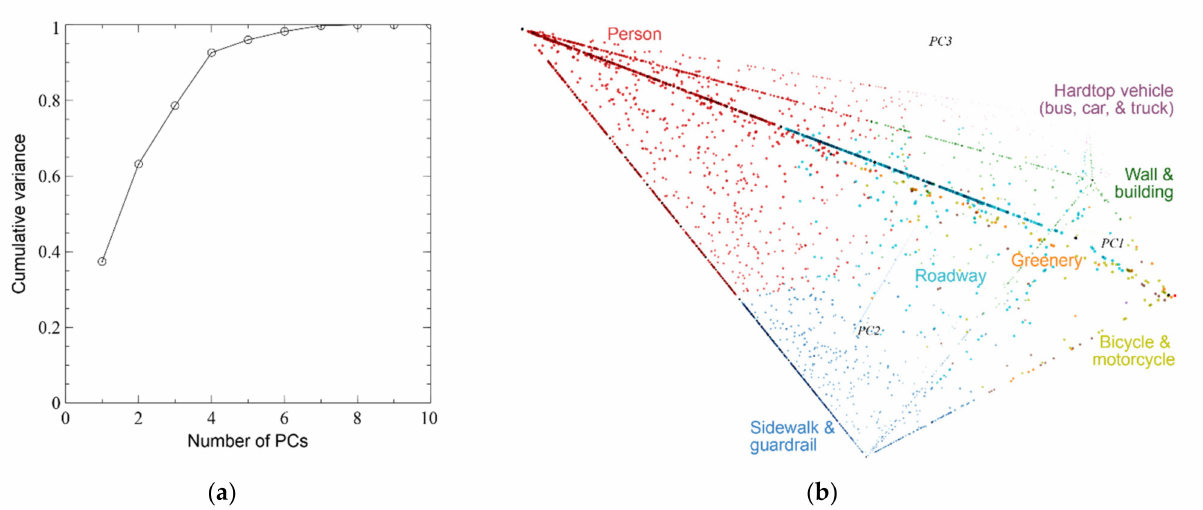
Figure 9. PCA results of the ground feature using eigen-decomposition. ( a ) Cumulative variance results of PCA; ( b ) the 3D data view in the top three PCs, where color indicates the most frequent feature and transparency shows the 3D depth.